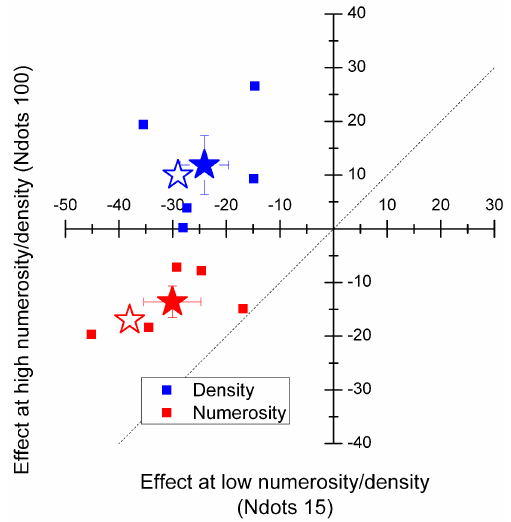
Figure 4. Effect of connectivity (normalized percentage distance between PSEs of isolated and connected stimuli: Equation 1 for numerosity (red) and density (blue) judgements. The effect for 100-dot stimuli is plotted on the ordinate against that for 15-dot stimuli (on the abscissa). Squares report single subject data, filled stars the between subjects average effects, open stars the effect calculated on the aggregated